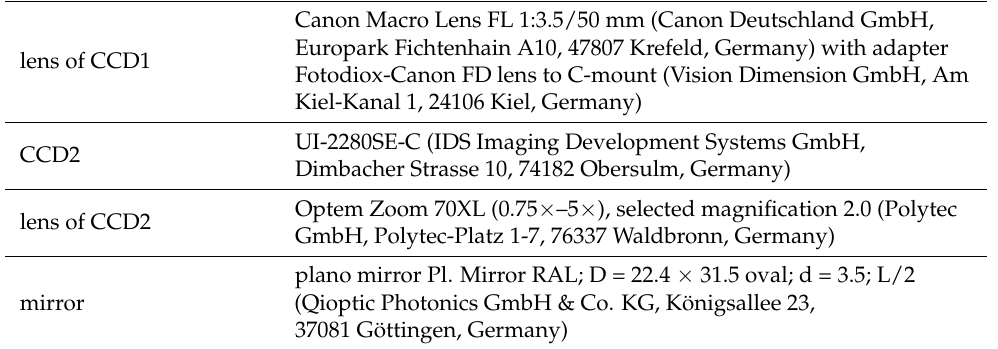
Table A1. Cont. Mach–Zehnder Interferometer: Visualization of Concentration Field